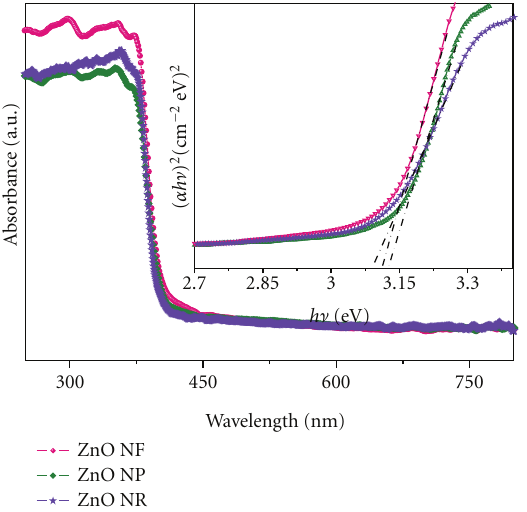
Figure 3: UV-Vis absorption spectra of ZnO nanoparticles, nano- flowers, and nanorods morphology. Inset shows the corresponding Tauc’s plot.